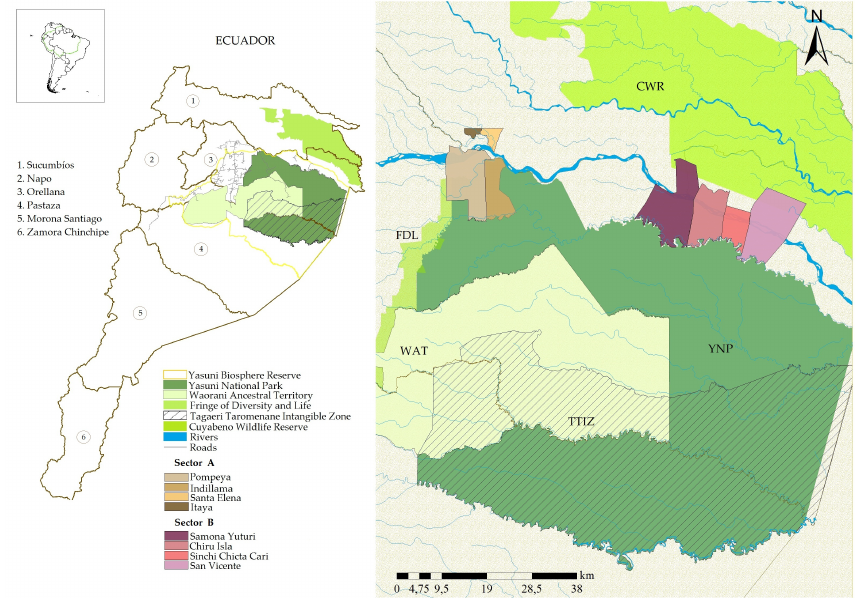
Figure 1. ( a ) Distribution of climatological (2000–2017) aerosol optical depth (AOD). The green box Figure 1. Sectors A and B located in the north of the Yasun í Biosphere Reserve (YBR) in the Ecuadorian indicates the East Asian region (110.5–122.5 ◦ E, 22.5–40.5 ◦ N), where AOD is the highest. ( b ) The black Amazon line denotes time series data of the AOD index, averaged over the green box area shown in ( a ). The blue line denotes normalized time series data with the linear trend removed from the black line. ( c ) The composite di ff erence of AOD during April–May–June (AMJ; high AOD minus low AOD). Regions with black cross-hatching indicate a statistical significance at a 95% confidence level.